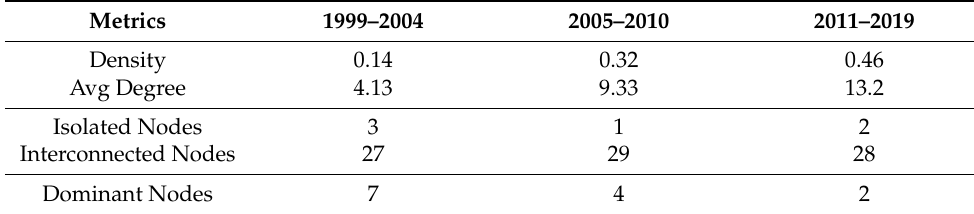
Table 5. Network metrics for 0.8 threshold level on the Unemployment variable.